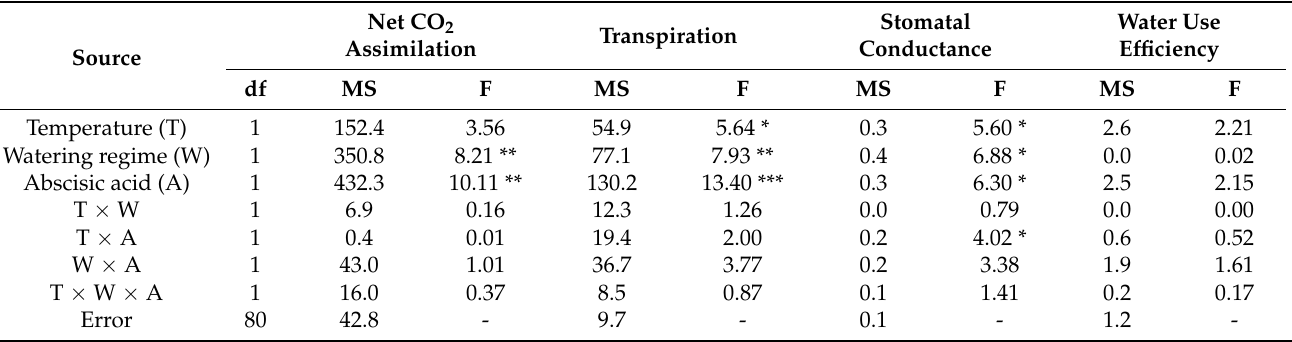
Table 9. Analysis of variance for the effects of temperature, watering regime, abscisic acid, and their interactions on the gas exchange of tomato plants.